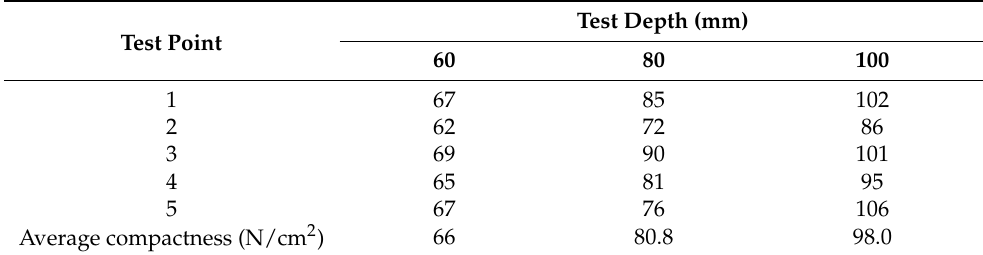
Table 1. Soil compactness.